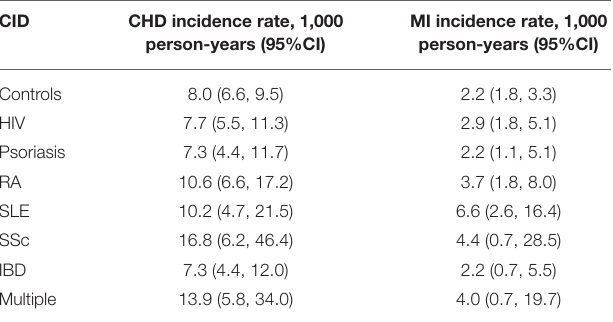
TABLE 2 | Crude coronary heart disease and myocardial infarction incidence rates per 1,000 person-years for controls and chronic inflammatory disease groups in the nested